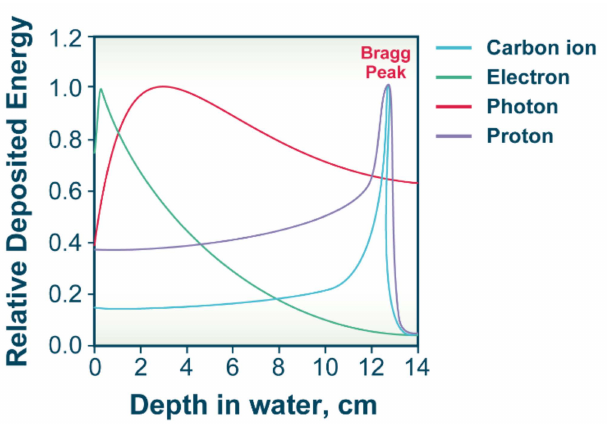
Figure 2. Energy deposition of different IR modalities. Idealized plots representing the energy deposition pattern of carbon ions, electrons, photons and protons in water. The main characteristic of charged particles is that they deposit their energy following a pattern known as the “Bragg